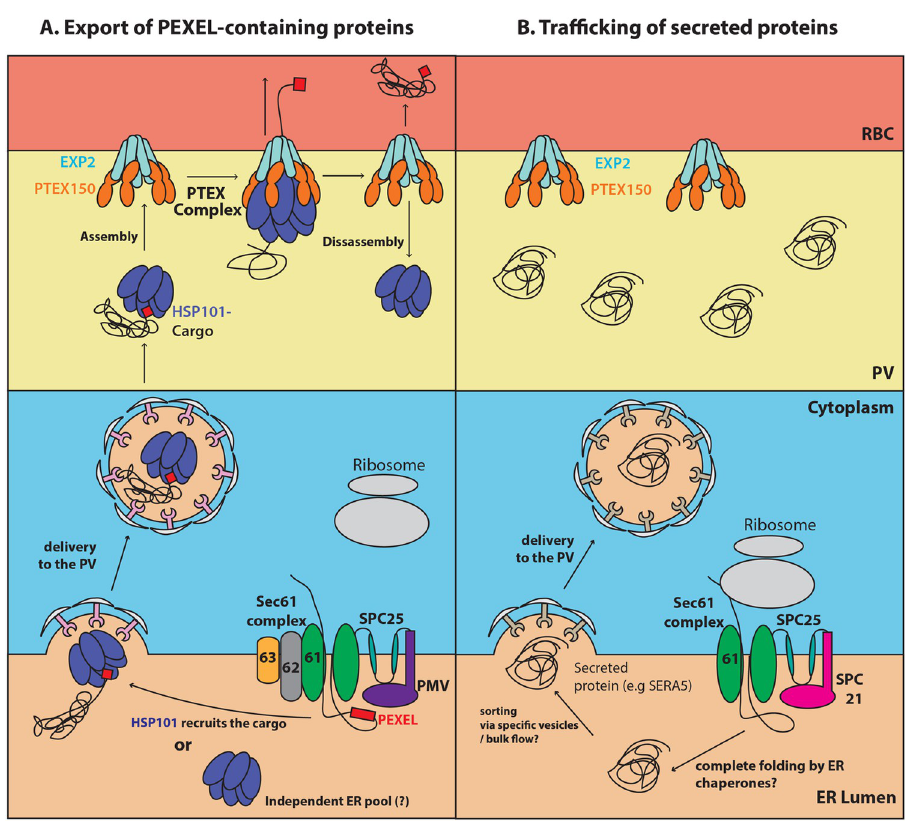
Fig 8. Model of PEXEL protein targeting to the vacuolar translocon by HSP101. (A) PEXEL-containing proteins are imported after translation into the ER via a Sec61/62/63-SPC25-PMV translocon [26] and are recognised by HSP101, either during import or after PEXEL processing, prior to their release into the ER lumen. HSP101-bound cargo is then trafficked to the parasite membrane via the vesicular trafficking system and released into the PV. HSP101 affinity for the PTEX150-EXP2 subcomplex at the vacuolar membrane drives reconstitution of the full PTEX complex capable of translocating the cargo into the host cell. The model depicted here is described for soluble PEXEL proteins, but it is possible that the same mechanism governs the trafficking of transmembrane proteins. (B) Proteins with a classical N-terminal signal sequence destined for the PV such as SERA5, are imported into the ER by the Sec61-SPC25-SPC21 complex [26]. After signal sequence cleavage, the released proteins are folded and secreted into the PV. Since these proteins are not bound to HSP101, they cannot translocate via PTEX.